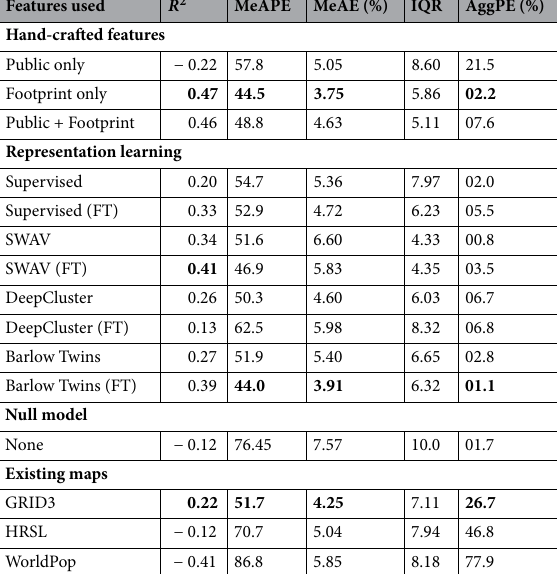
Table 3. Population model validation performance for (top) manually and automatically extracted features, along with (bottom) test performance of existing maps. See section “Results” for metric definitions. IQR is interquartile range of absolute errors. Bold indicates best in category. FT